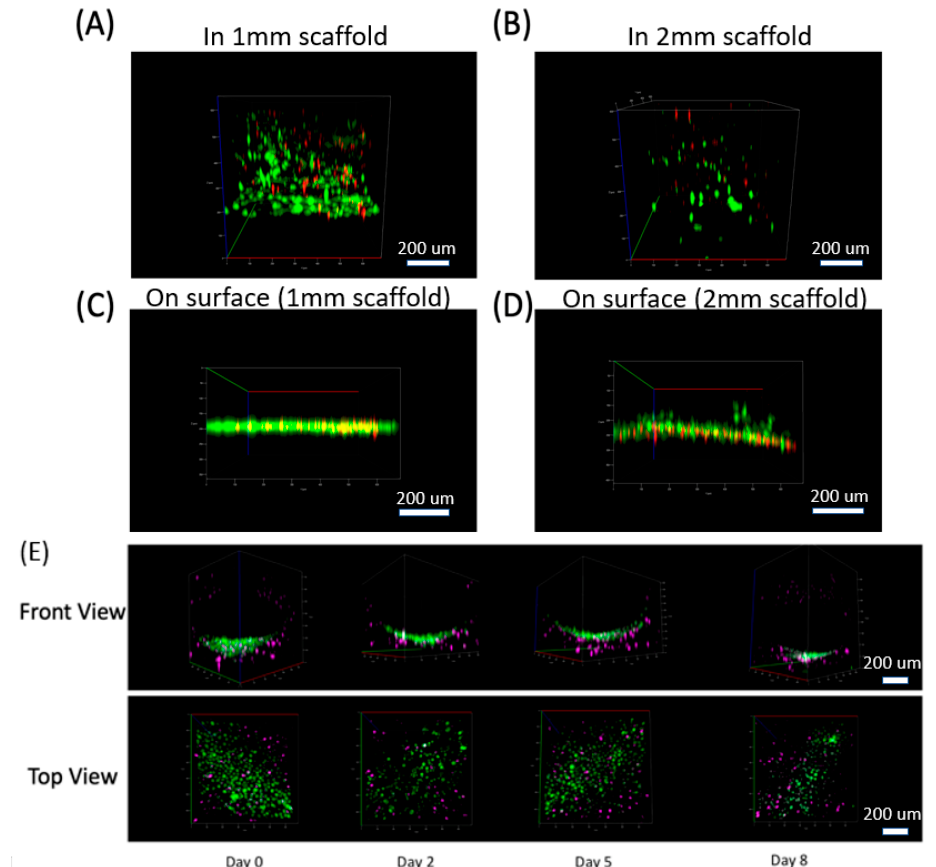
Figure 3. 3D distribution of cells in our collagen scaffold. Cells distribution in 3D (front view) at Day 7 for 4 samples: ( A ) Cells seeded in 1 mm thick collagen scaffold, ( B ) 2 mm thick collagen scaffold, and cells cultured on the surface of ( C ) 1 mm thick collagen and ( D ) 2 mm thick collagen. (For A-D. Green: Live cells stained by Calcein AM. Red: Dead cells stained by ethidium homodimer). ( E ) Co-culture system for C2C12 cells in our 3D scaffold with HUVEC cells cultured in the channel (lower half of the channel shown here). HUVEC cells attached to the channel wall and formed a curved distribution along the circular channel wall. See Video S1 as well. (For E. Purple: C2C12 cells stained by Celltracker Deepred. Green: HUVEC cells stained by Celltracker Green).